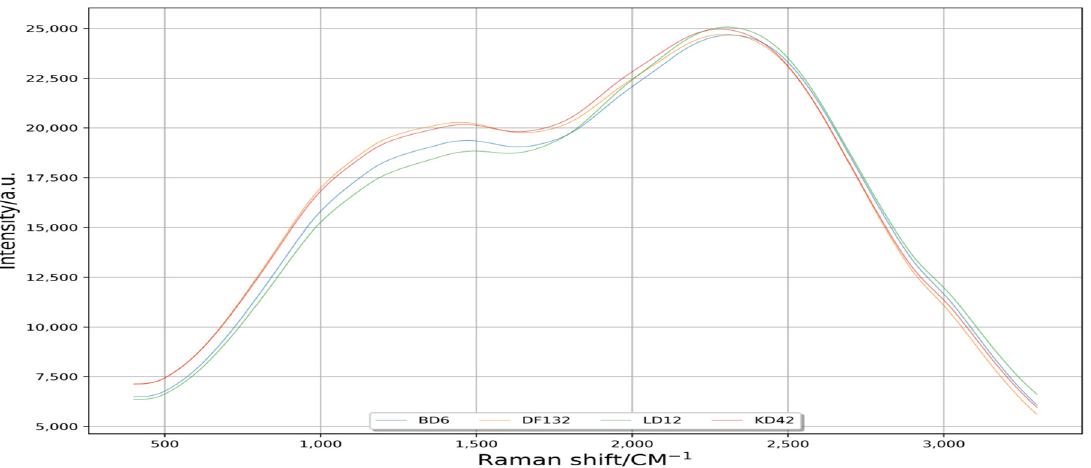
Figure 3. Spectral curves of disturbance reduction by filtering method. Raman shift is the reciprocal of wavelength, unrelated to the frequency of incident light and only related to the vibration frequency of sample molecules, and its range is 200–3400 cm − 1 . Intensity is the intensity of Raman scattering, which is the anti-Stokes line; the anti-Stokes line is the scattering light of frequency shifted light from monochromatic incident light in a molecule.